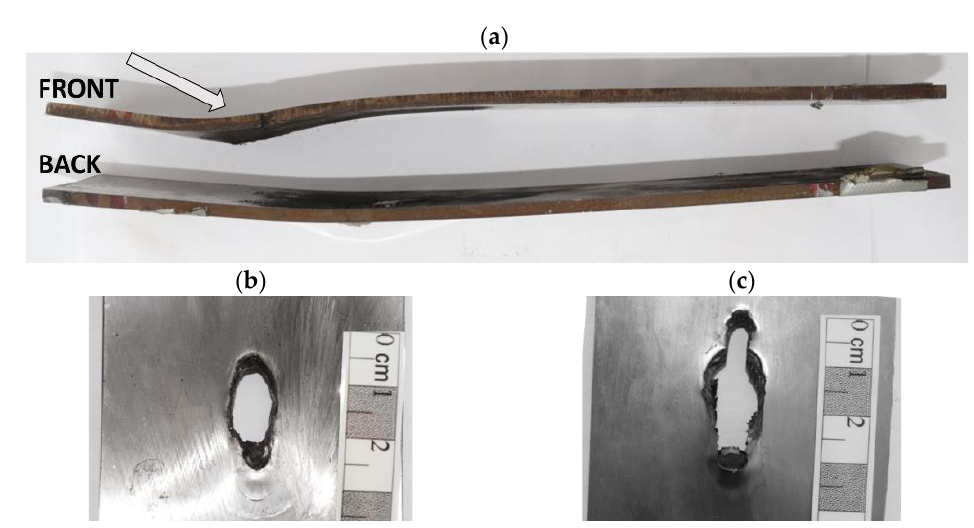
Figure 10. ( a ) Deformation of the side steel plates. Entry ( b ) and exit holes ( c ).